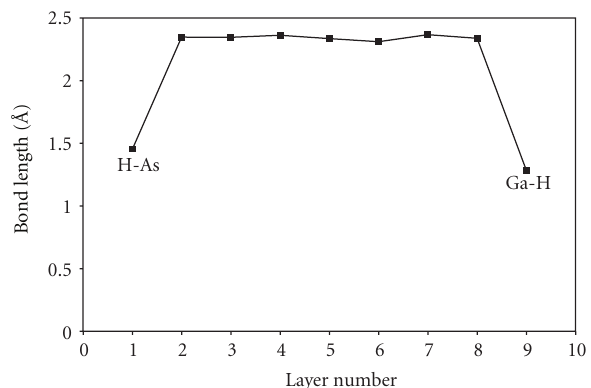
Figure 4: The variation of bond length between atoms starting from the arsenide hydrogenated surface (H–As bond) until we reach the tenth layer at the hydrogenated gallium surface (Ga–H bond) of the nanocrystal using cluster-HF geometrical optimization.